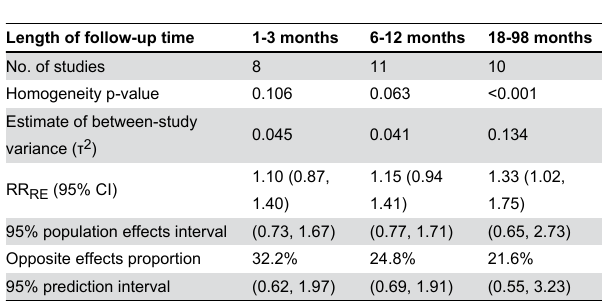
Table 2. Meta-analysis results for the effect of TB treatment on mortality, by length of follow-up